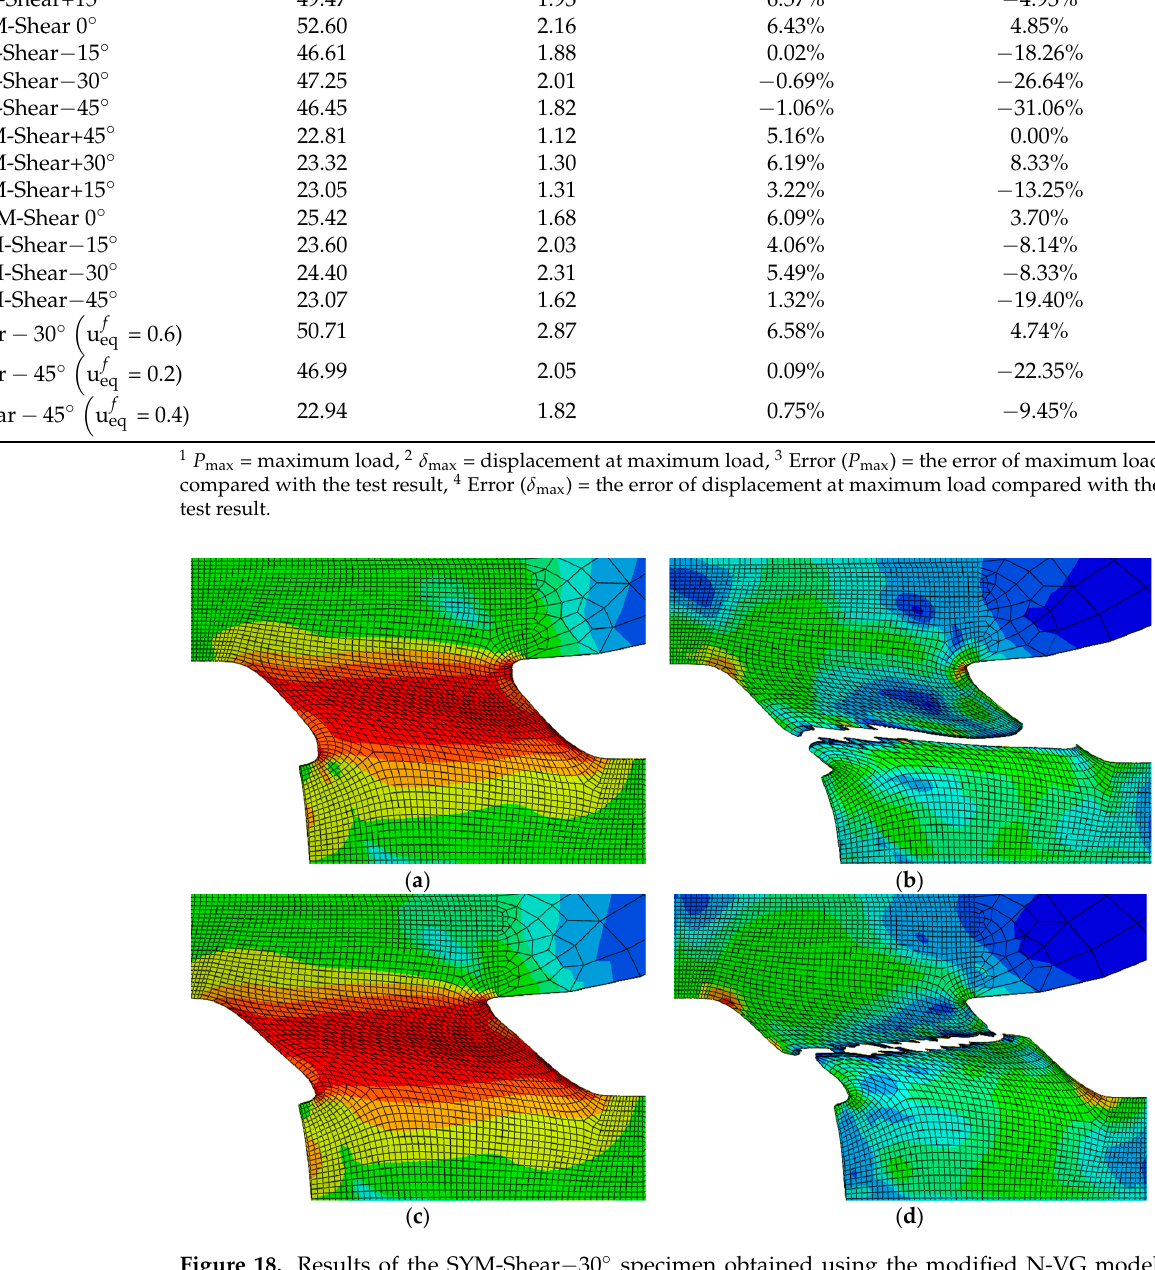
= = ); ( b ) fracture path ( f 0 eq u ); ( c ) stress = u eq